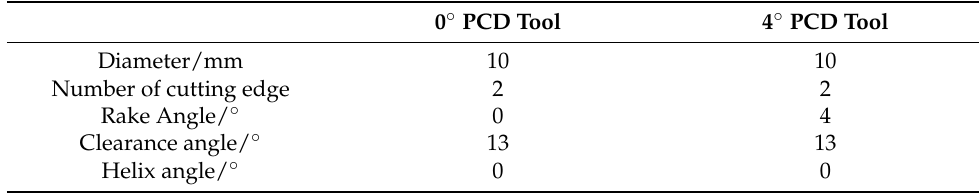
Table 2. Specific parameters of the tools.